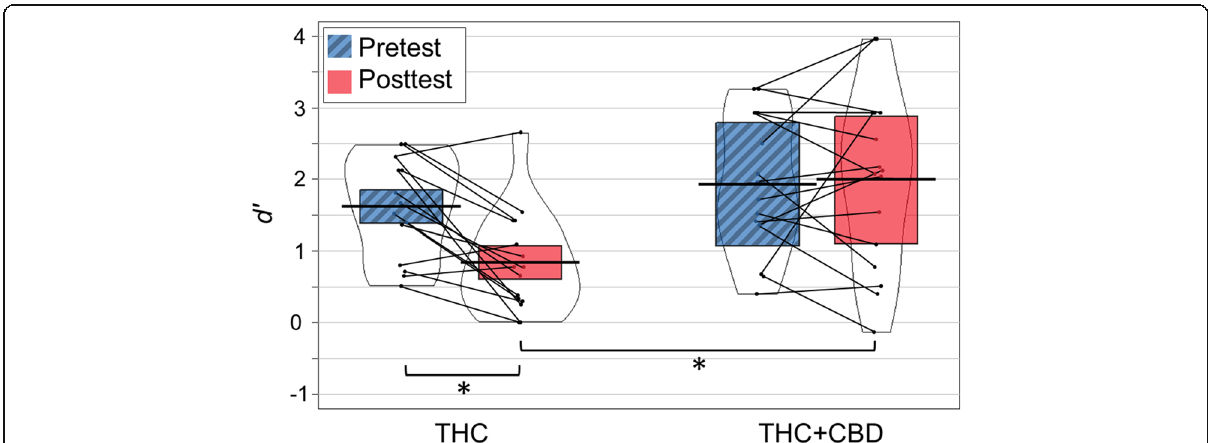
Fig. 3 Accuracy d ′ for pretest and posttest, for the two strain groups: THC and THC + CBD. Colored regions represent the 95% within subject confidence intervals (Morey 2008). Thick black lines represent the mean. Individual data points represent the mean d ’ for each participant. Thin black lines connect individuals across conditions. Asterisks show results of the Bonferroni post-hoc tests (* p bf <